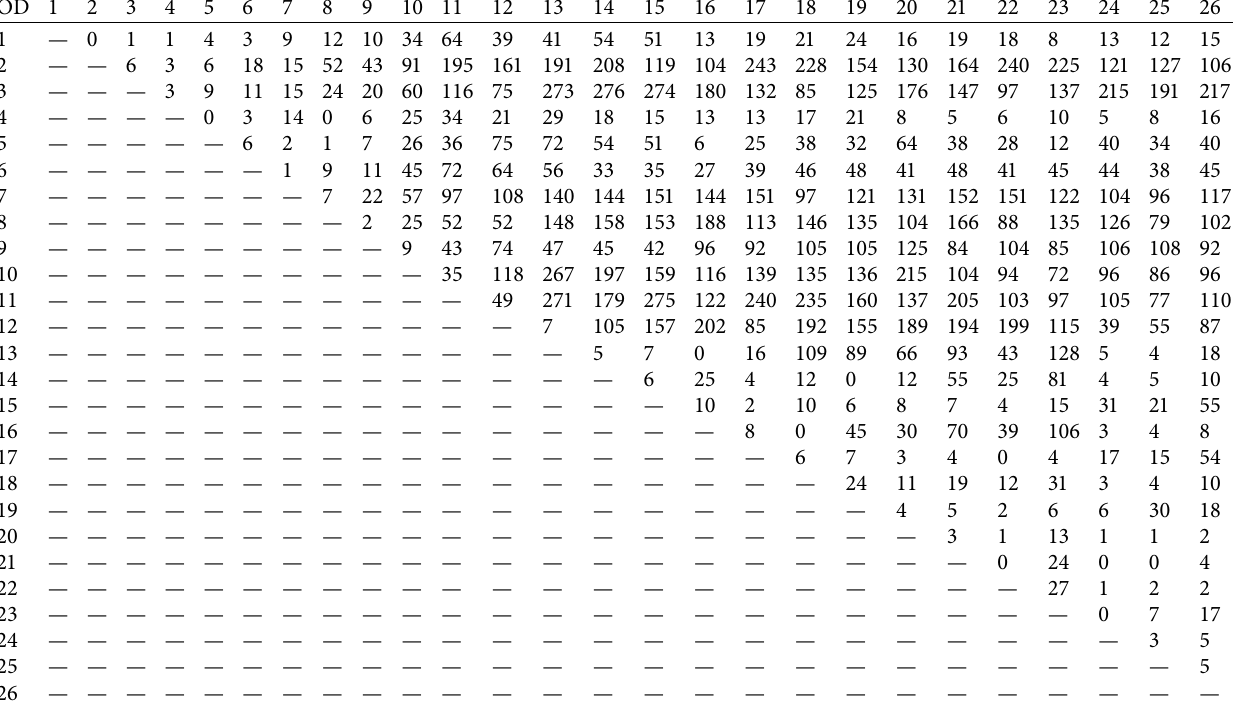
Table 4: The passenger OD matrix (upward direction) during the study